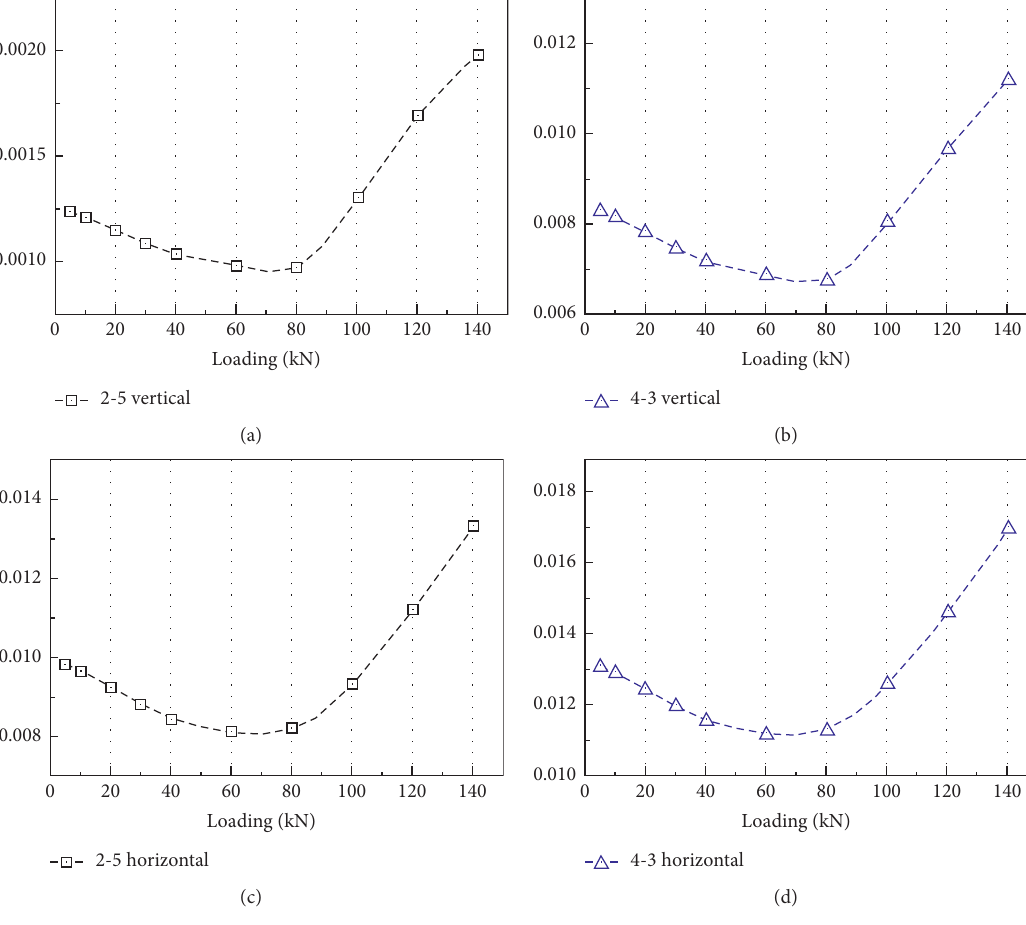
Figure 10: Slopes of stress curves in the free zone (take monitoring points 2-5 and 4-3 as an